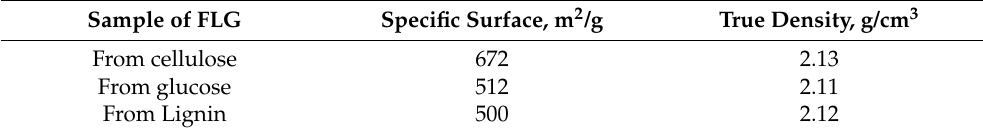
Table 1. Specific surface area and true density of FLG nanosheets synthesized from various biopol ‐ ymers.